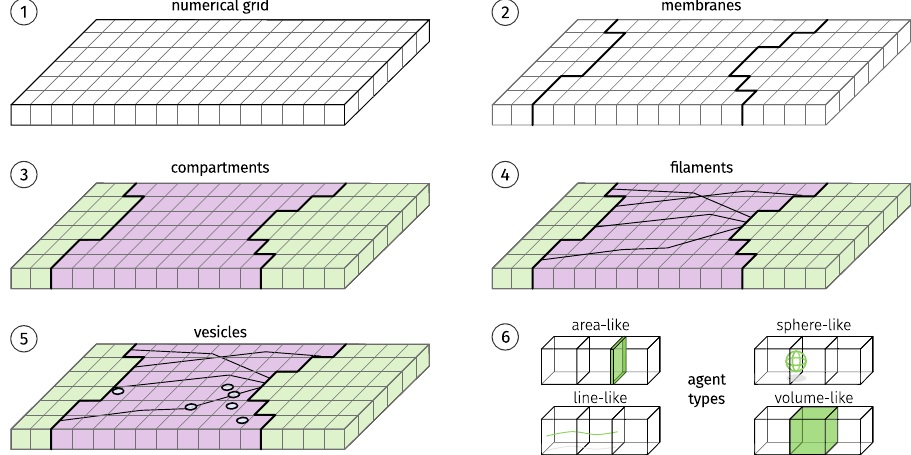
Fig. 7 Components of the simulation. First, the simulation space ( 1 ) is tiled into a regular grid, and used for numerical calculation and spatial indexing. Next, the membrane agents ( 2 ) determine the compartments ( 3 ) of the simulation. Each cell of the grid is assigned a concentration of chemical entities. Finally, fi laments ( 4 ) and vesicles ( 5 ) are placed in the simulation. All agents are implementations of abstract agent types ( 6